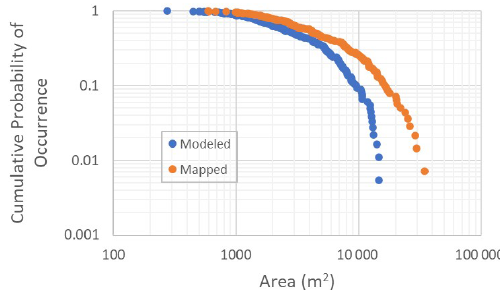
Figure 16. Magnitude–frequency comparison between modeled (blue) and mapped (orange) landslides on the north shore of Cowichan Lake,